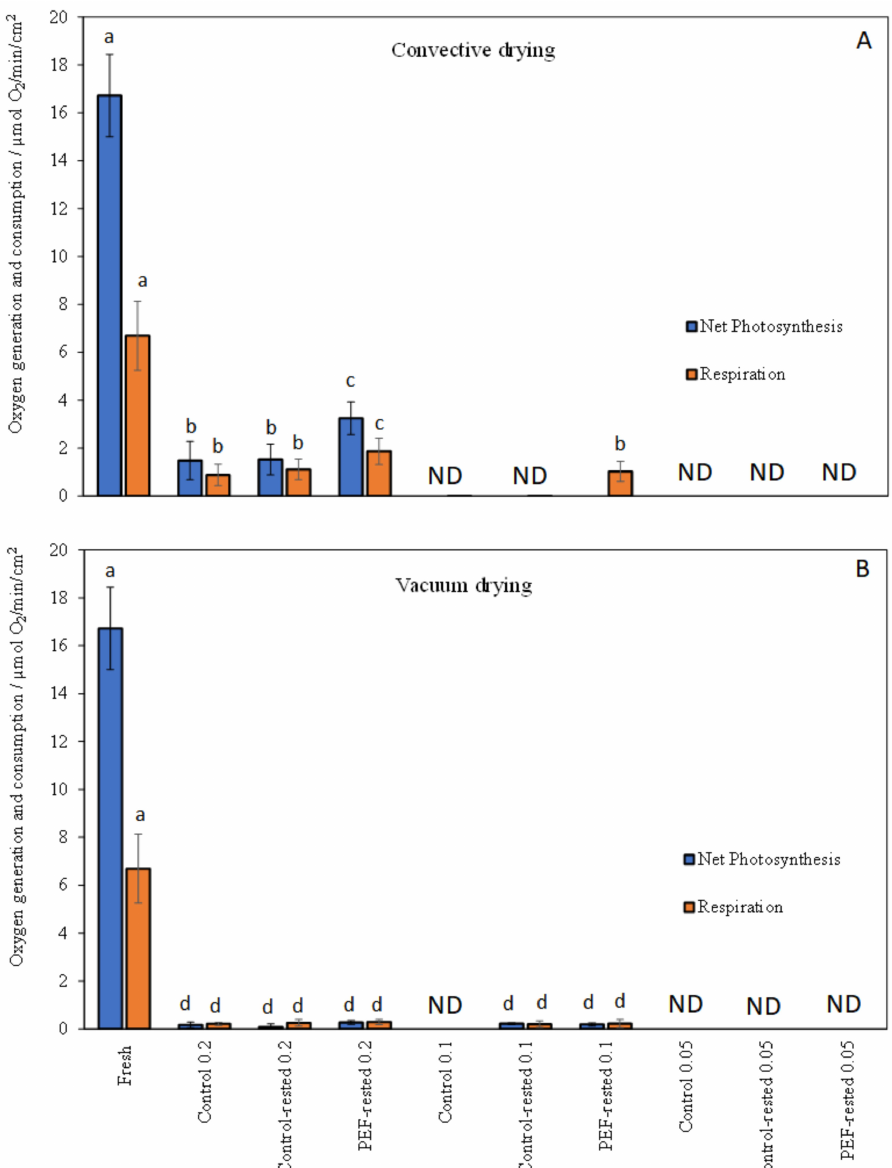
Figure 5. Oxygen generation and consumption of rehydrated Thai basil leaf samples subjected to different pretreatments (control, control-rested, and PEF-rested) prior drying using convective ( A ) or vacuum drying ( B ). The measurements were done with the light source on (photosynthesis), and light source off (respiration). Different letters (a–d) next to the error bars indicate statistically significant differences ( p < 0.05). ND: not detectable. Plotted data are average and standard deviation from 21